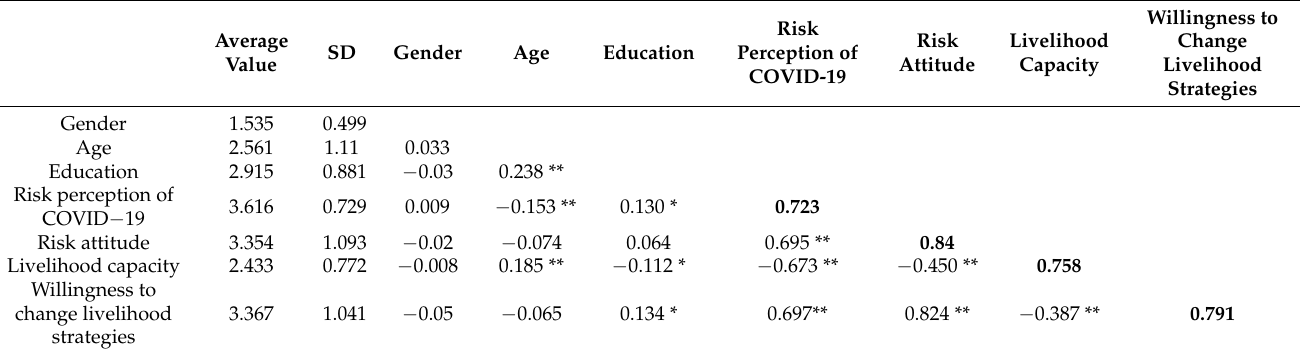
Table 3. Correlation coefficients and discriminant